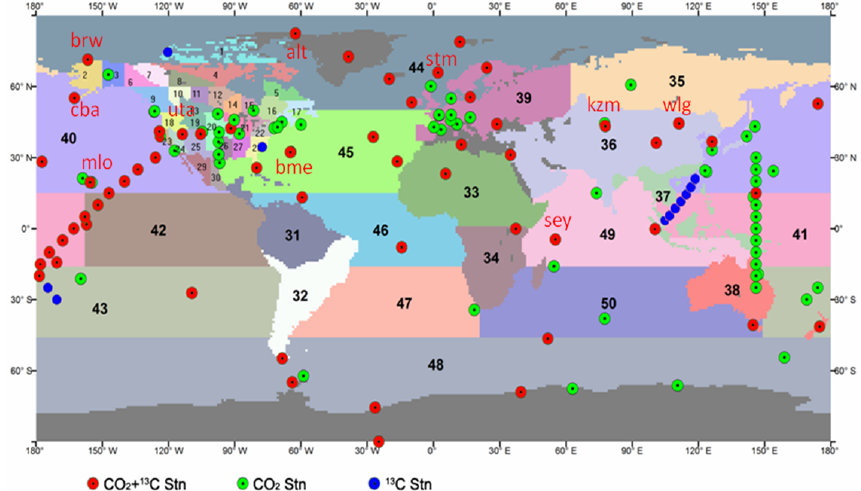
Figure 1. A global nested inversion system with a focus in North America, in which oceans are divided into 11 regions and land areas are divided into 9 large and 30 small regions outside and within North America, respectively. Also shown are CO 2 and 13 CO 2 observation stations included in the GLOBALVIEW database and used in this study; 10 of the stations are marked with their names because they are selected to compare prior and posterior concentrations in Fig.